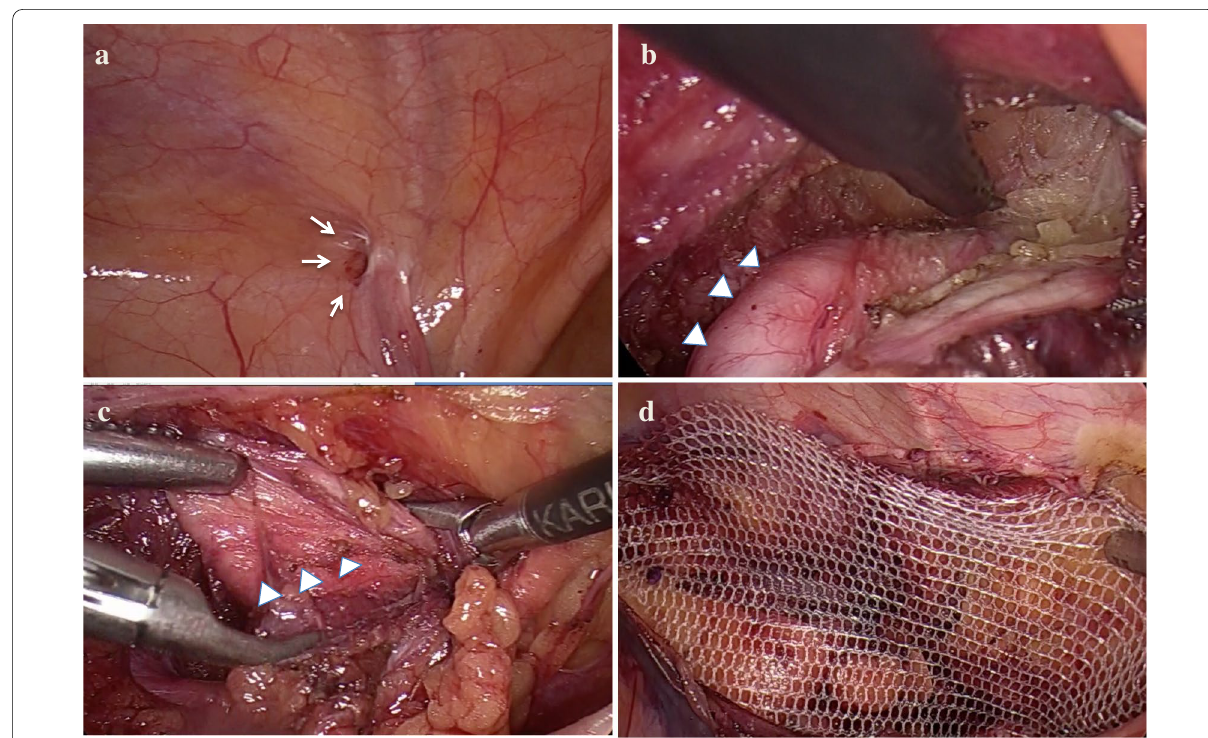
Fig. 2 Intraoperative photos. a The internal inguinal ring is weak, but no obvious hernia sac (white arrows). b Type B HCN, completely located in the inguinal canal (white arrowheads). c The round ligament was cut off and the posterior wall of HCN was dissociated from the cephalic side until the HCN was finally removed completely. d A lightweight polypropylene mesh was introduced to cover the inguinal myopectineal triangle and absorbable tacks were used to fix the